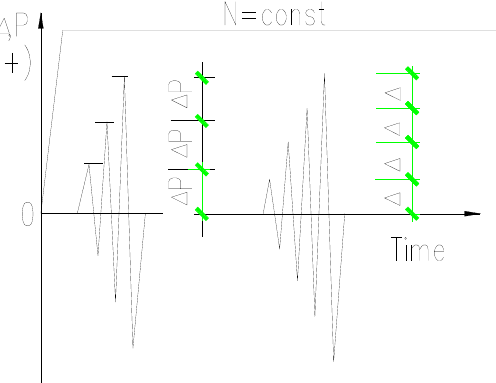
Figure 6. Layout of test loading (left: loading-controlled Δ P = 10 KN; Right: displacement-controlled Δ = 3 mm.